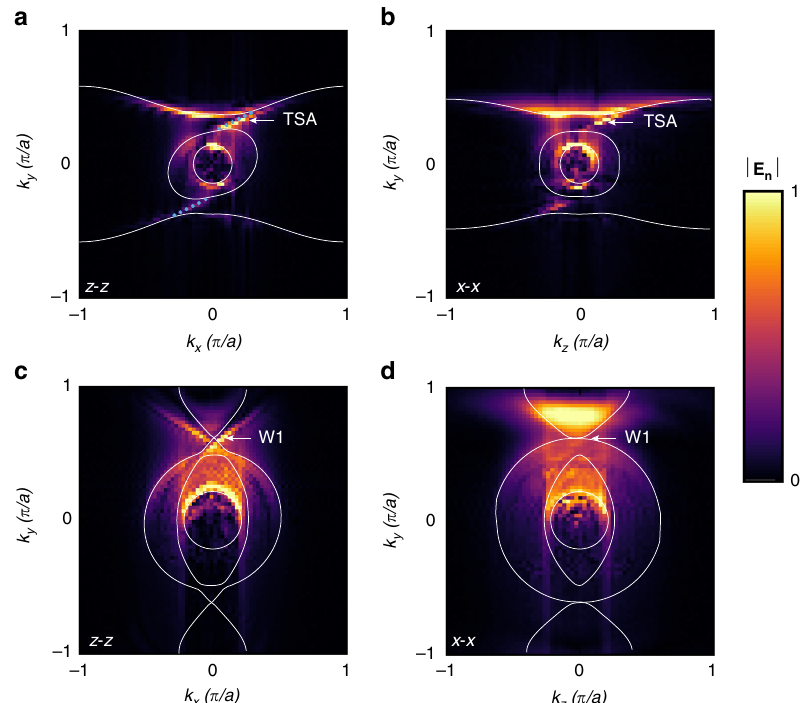
Fig. 3 Photonic equi-frequency contours at two different frequencies. Scanned electric fi eld with the con fi guration of z (polarized source) − z (polarized probe) on the top surface at a 5.46 GHz and c 8.13 GHz. Scanned results with the con fi guration of x (polarized source) − x (polarized probe) on the side surface at b 5.46 GHz and d 8.13 GHz. For x polarized source, the antenna is oriented in the – x direction. In each the innermost solid circle indicates the light cone. The other solid curves present simulated bulk states of the chiral hyperbolic metamaterial from CST Microwave Studio. Data in the k y < 0 range are back-scattered from the edge of the sample. Topological surface-state arcs ( TSA ) and type-II Weyl points (W1) are indicated by the white arrows. In a the dotted cyan lines indicate simulated TSA. The crossing points in c , d show another characteristic feature of type-II Weyl points as shown in Fig. 1a and b density of states (DOS) planes. In all panels , the normal components of the electric fi elds are normalized to the same reference